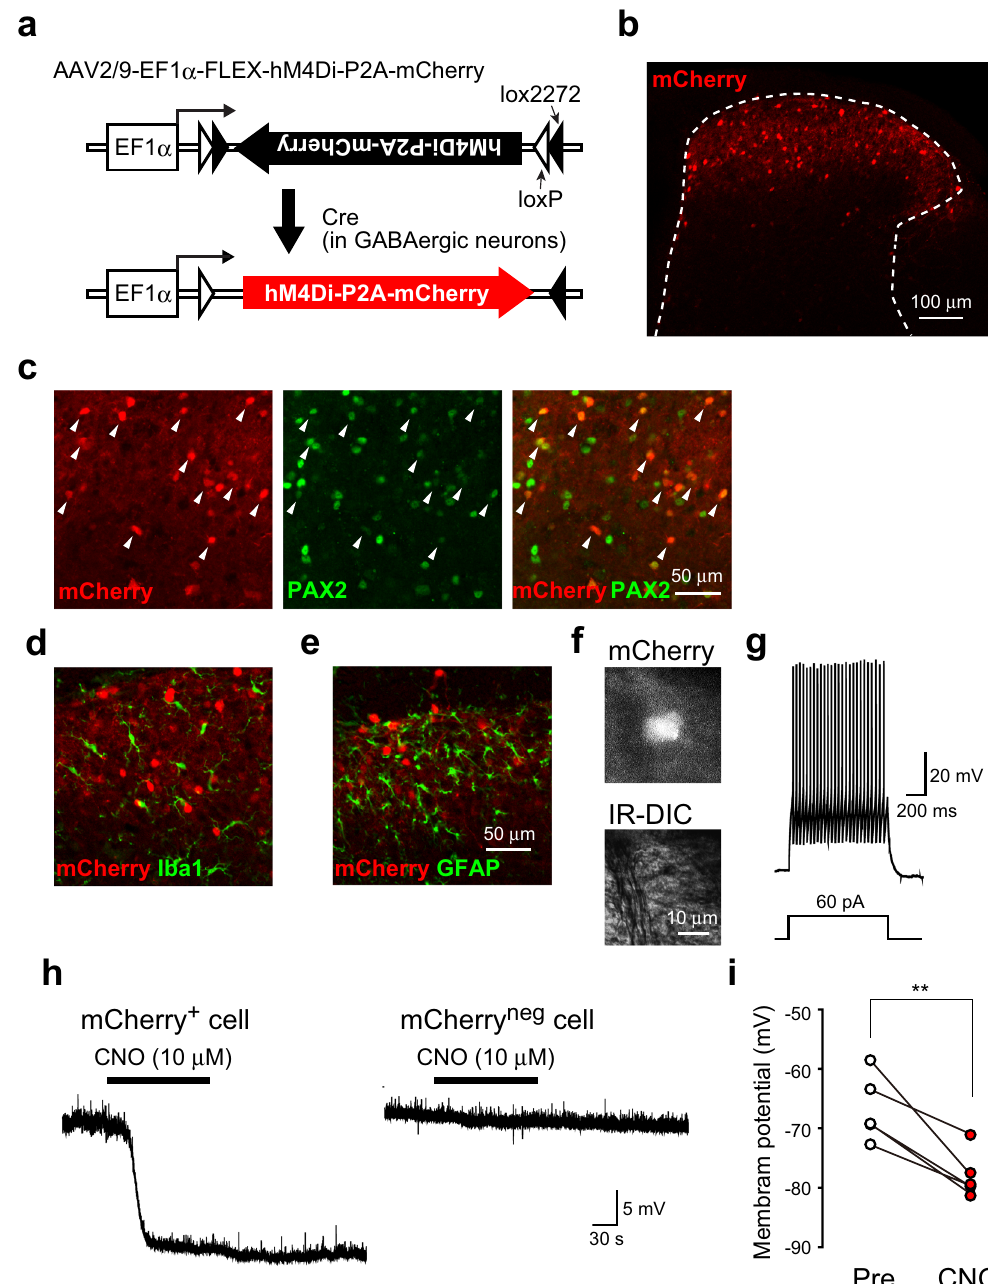
Figure 1. Vgat-Cre + SDH interneuron-specific hM4Di expression. ( a ) Schematic illustration of the FLEX switch system. AAV2/9 vector carrying EF1 α and an inverted hM4Di-P2A-mCherry sequence flanked by loxP and lox2272 on both sides. Cre-dependent genetic inversion switch of the hM4Di-P2A-mCherry sequence occurs in Cre-expressing GABAergic SDH interneurons of Vgat-Cre mice. ( b ) mCherry expression in the SDH of mice 4 weeks after intra-SDH injection of AAV2/9-FLEX-hM4Di-P2A-mCherry. ( c–e ) Immunohistochemical identification of mCherry-expressing cells using cell-type specific markers (green; ( c) PAX2; ( d) Iba1; ( e ) GFAP). Arrowheads indicated mCherry + cells with PAX2 immunofluorescence. ( f ) Photomicrographs of mCherry + SDH neurons (upper, epifluorescence; lower, Nomarski optics) in spinal cord slices taken from Vgat-Cre ;AAV-hM4Di FLEX mice. ( g ) Representative firing pattern of an mCherry + SDH neuron in a spinal cord slice. ( h ) Representative traces of the effect of CNO (10 μ M) on mCherry + (left) and mCherry neg (right) SDH neurons. ( i ) Quantification of membrane potentials in mCherry + SDH neurons before (Pre) and after application of CNO (n = 5, ** P <